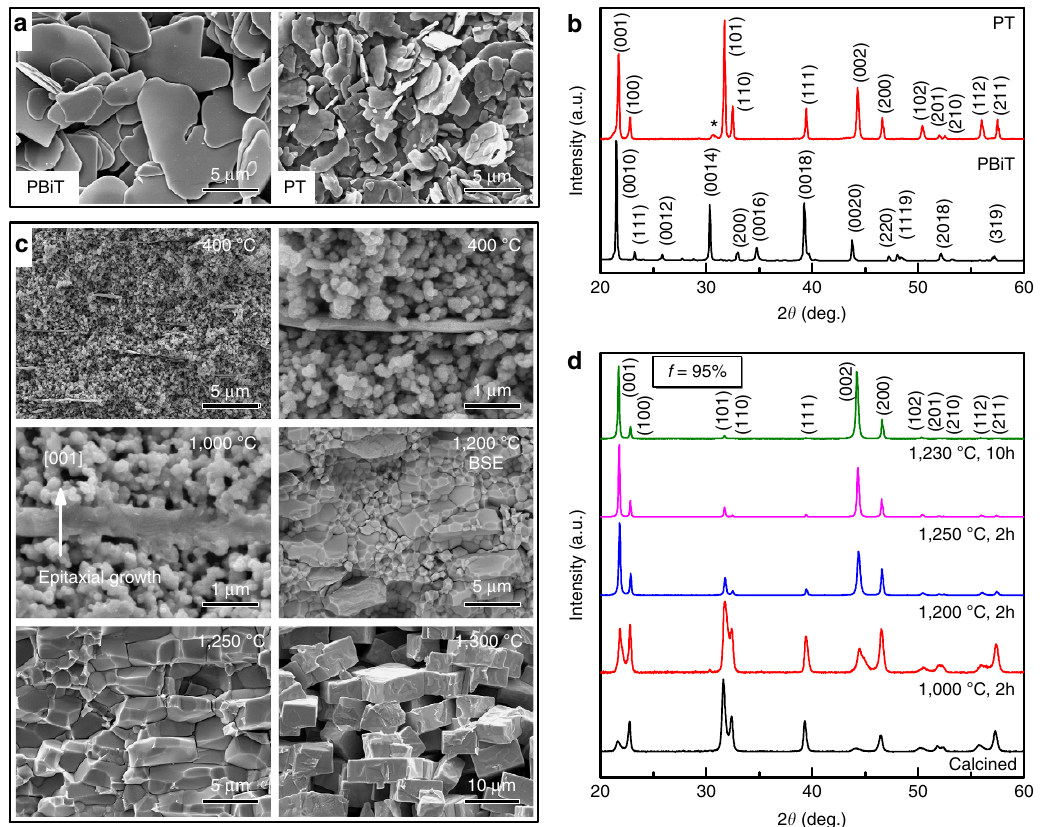
Figure 2 | Microstructures and crystal structures of templates and textured ceramics. ( a ) SEM images of PBiT precursors and PT templates. ( b ) X-ray diffraction patterns of synthesized PBiT precursors and PT templates. ( c ) Backscattered electron (BSE)-SEM images of PT textured SM-PT ceramics sintered at different temperature for 2h. ( d ) X-ray diffraction patterns of calcined SM-PTmatrix powders and textured SM-PTceramics sintered at different temperature and soaking